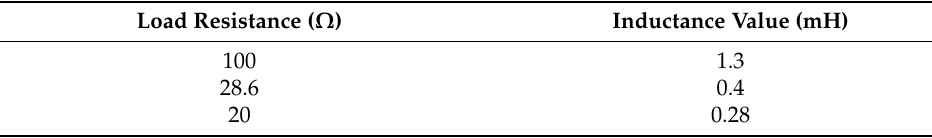
Figure 16. DC microgrid experimental platform. Table 4. Parasitic inductance value of resistive load. Table 5. Parameters of experimental platform.